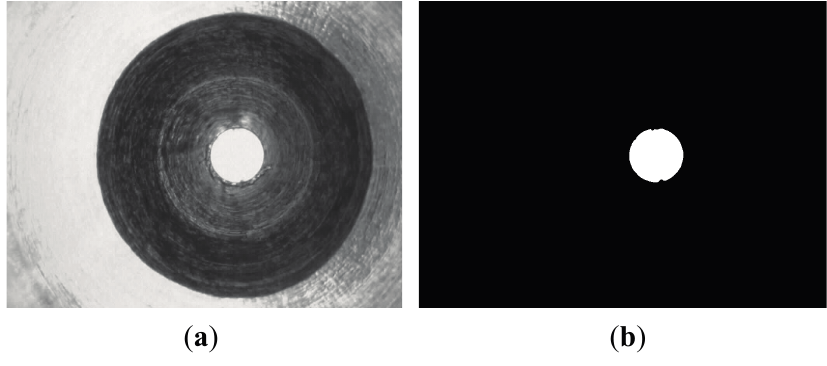
Figure 5. Outlet image segmentation. ( a ) Orignal image; ( b ) Outlet